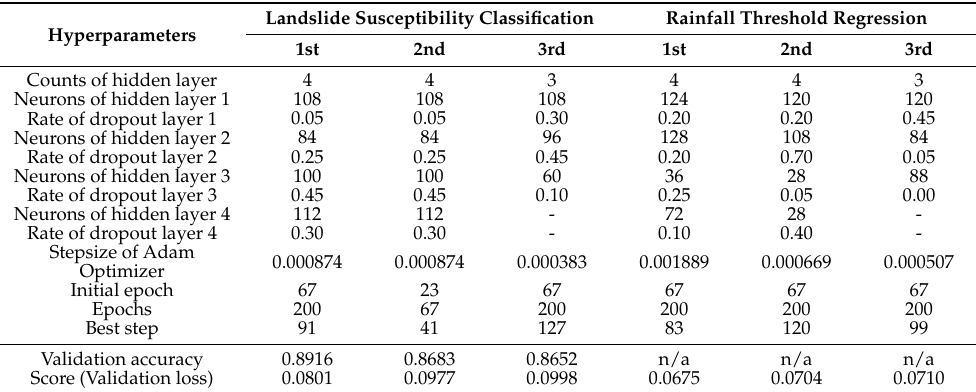
Table 4. Top 3 ranking of hyperparameter tuning results for